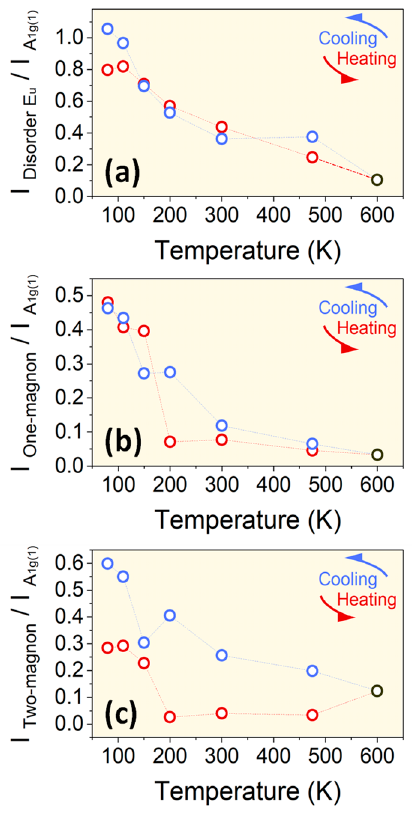
Figure 6. Heating (red color) and cooling (blue color) curves of the relative intensity between 80 and 600 K related to the modes ( a ) disorder E u , ( b ) one-magnon, and ( c ) two-magnon mode, with respect to the mode A 1g(1) . The black symbol represents the returning temperature (600 K).